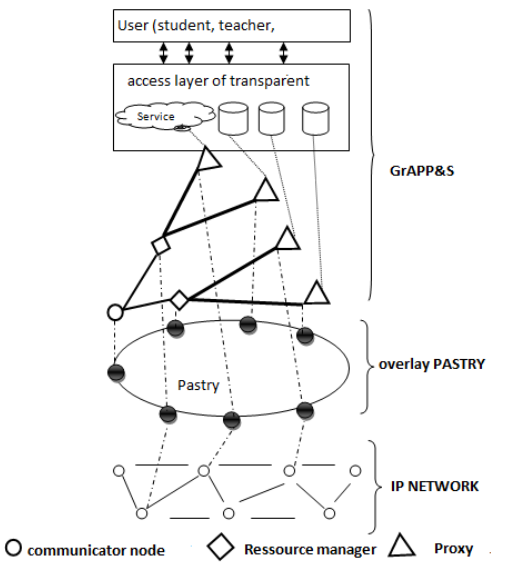
Figure 3. Deployment of nodes GRAPP&S on